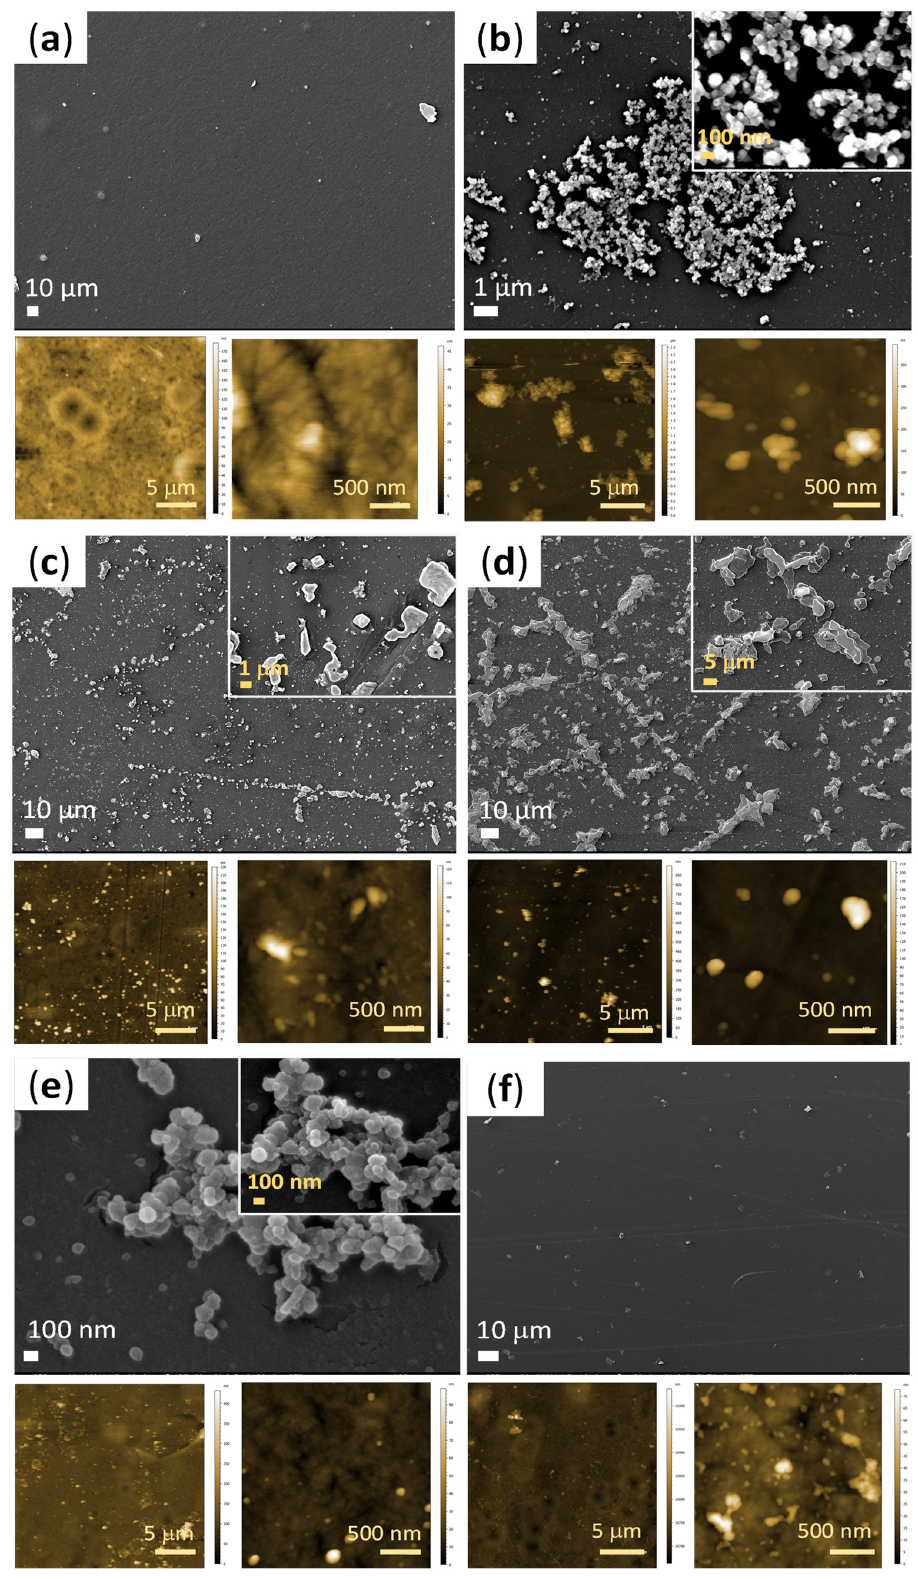
Figure 8. FE-SEM images of samples after 7 days of incubation in SBF: ( a ) PP; ( b ) PP-PDA; ( c ) PP-PDA-PEI; ( d ) PP-PDA-PEI-TEOS; ( e ) PP-PDA-PEI-TEOS-W; ( f ) PP-PDA-PEI-TEOS-A; and corresponding AFM 2D-height topography maps at different magnifications.